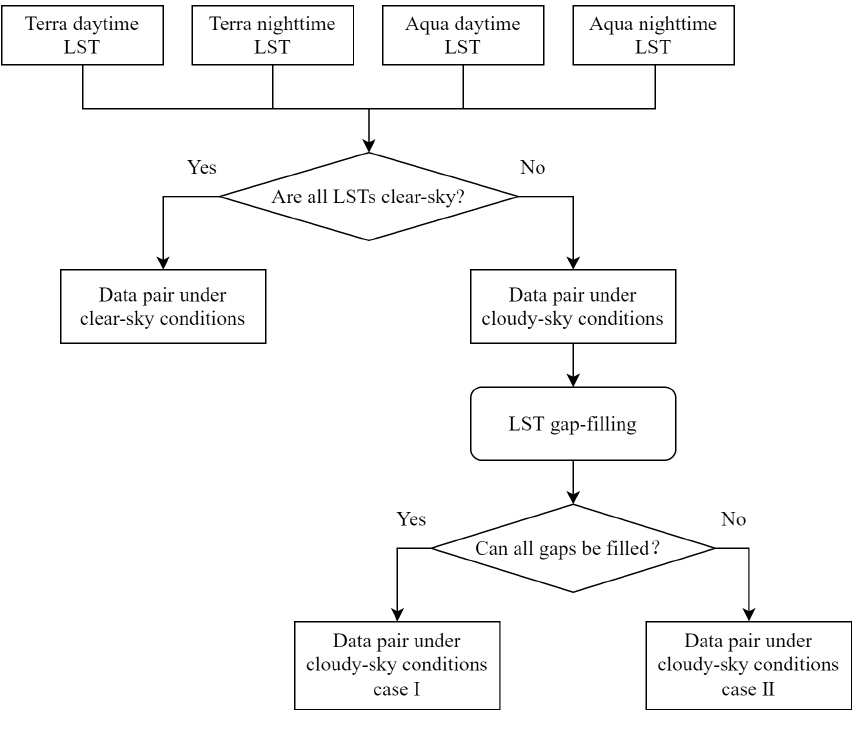
Figure 3. The criteria for the weather-condition-based division of a data pair.